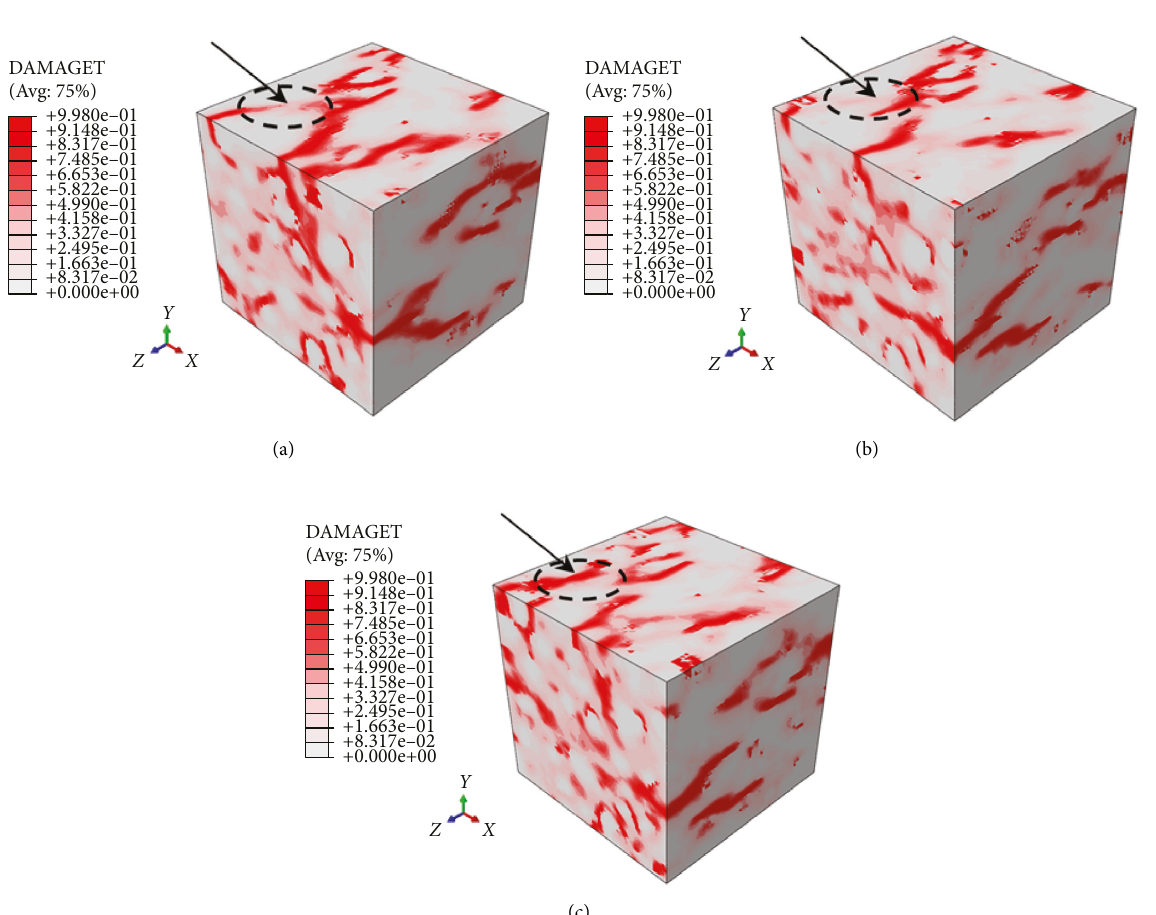
Figure 11: Tensile damage nephogram of concrete with different contents of rubber. (a) Rubber contents is 3%, (b) rubber contents is 5%, (c) rubber contents is 8%.